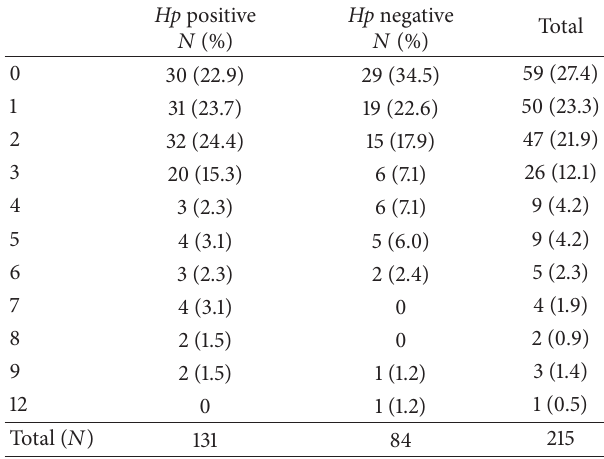
Table3:Numberofothermicrobialspeciesisolatedfromindividual